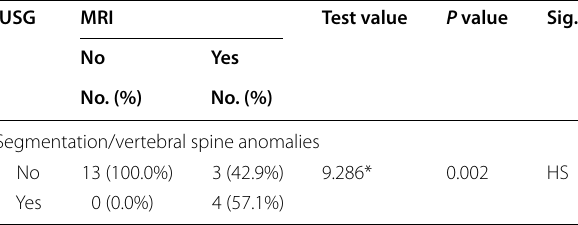
Table 8 Relation between USG and MRI as regarding diagnosis of segmentation/vertebral spine